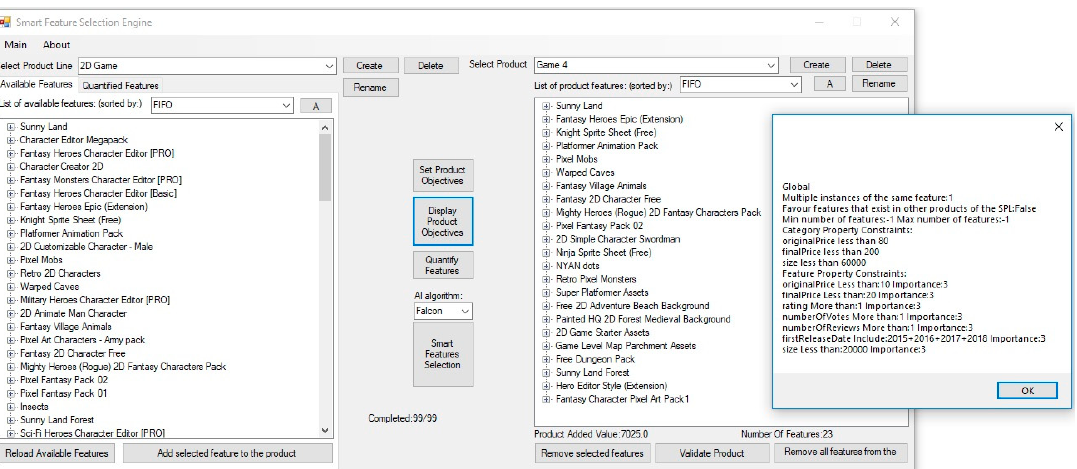
Figure 5. FSE main window.